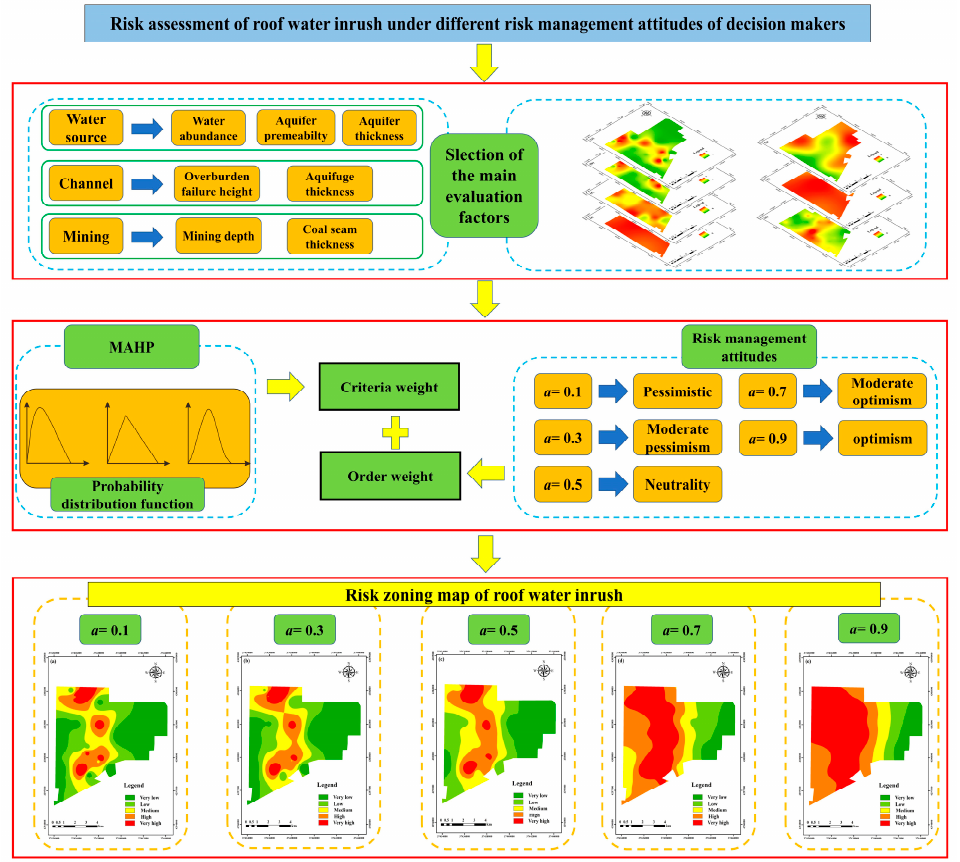
Figure 5. Ordered weighted averaging flowchart.